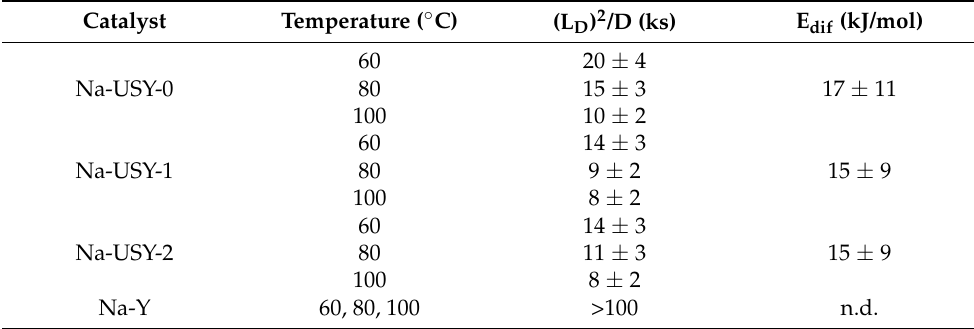
Table 5. Characteristic mesitylene diffusion times from ZLC